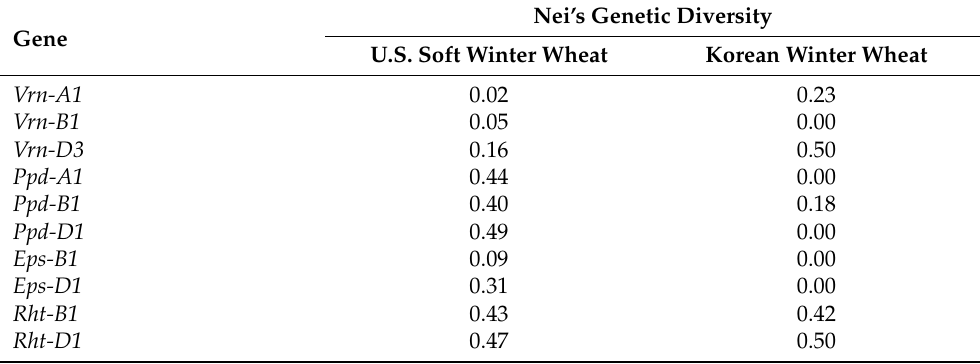
Table 2. Genetic diversity of the vernalization ( Vrn ), photoperiod ( Ppd ), earliness per se ( Eps ) and